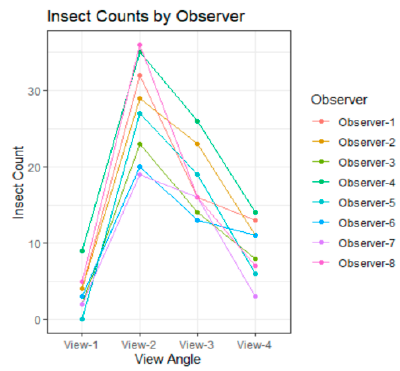
Figure 2. Number of insect visits to vegetation binned by each one-minute view for each observer. Note, all observers counted the most insects in view 2, followed by view 3, then view 4, with view 1 always being the lowest count per observer.